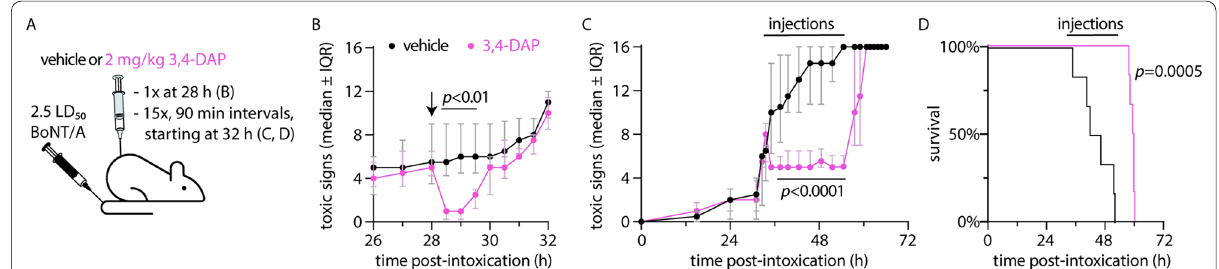
Fig. 1 Bolus administration of 2 mg/kg 3,4‑DAP reverses clinical signs of botulism and prolongs survival. A Summary of experimental models. B Median interquartile ratio (IQR) toxic signs for rats given a single injection of vehicle (black) or 3,4‑DAP (pink) at 28 h after challenge with 0.44 ng/ ± kg BoNT/A (2.5 LD 50 BoNT/A; n 4 per group). Toxic signs were monitored at 30 min intervals. Arrow indicates time of injection. (C, D) Median = toxic signs ( C ) and survival curves ( D ) for rats given 15 injections of vehicle (black) or 3,4‑DAP (pink) at 90 min intervals, starting 32 h after challenge with 2.5 LD 50 BoNT/A (n 6 per group). Black lines above graphs indicate treatment period during which injections were administered. Specific = details on n ‑values and statistical comparisons for this and subsequent figures are presented in Additional file 5: Table